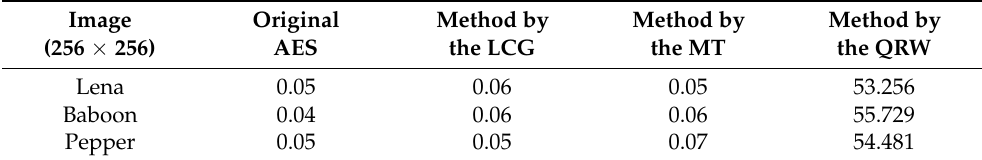
Table 9. The performance time of the proposed